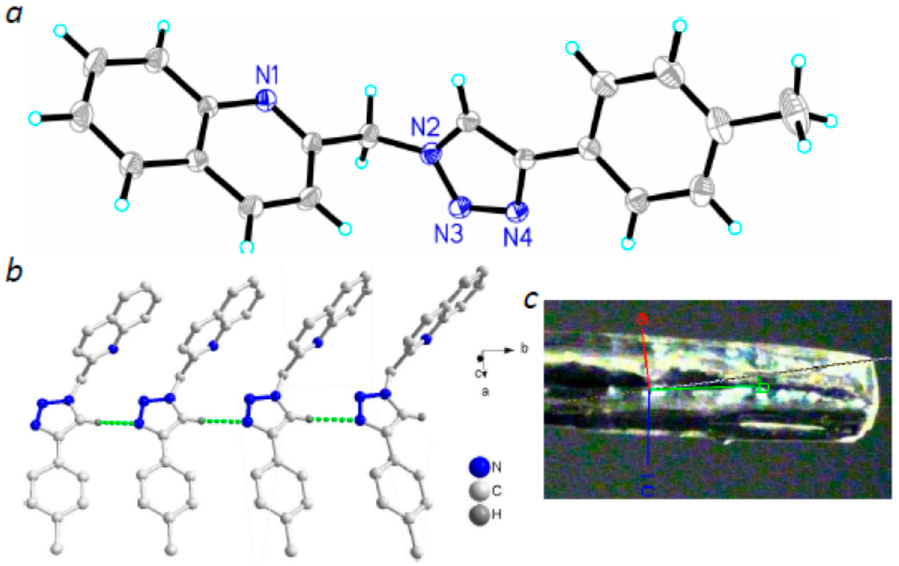
Figure 3. Molecular structure of 3 ( a ); H-bond interactions in 3 ( b ); Crystal image with lattice directions of 3 ( c ).